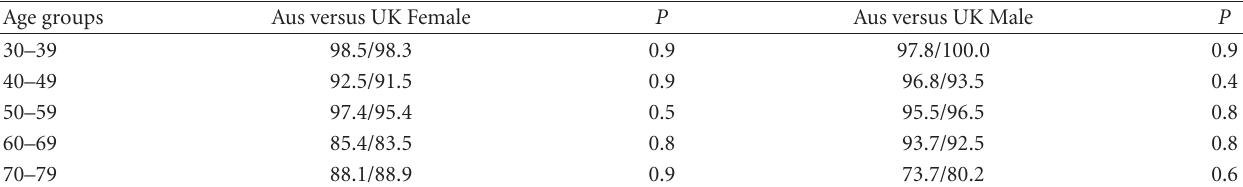
Table 1: Mean TESS at di ff erent age groups split by country and gender and statistical relevance.